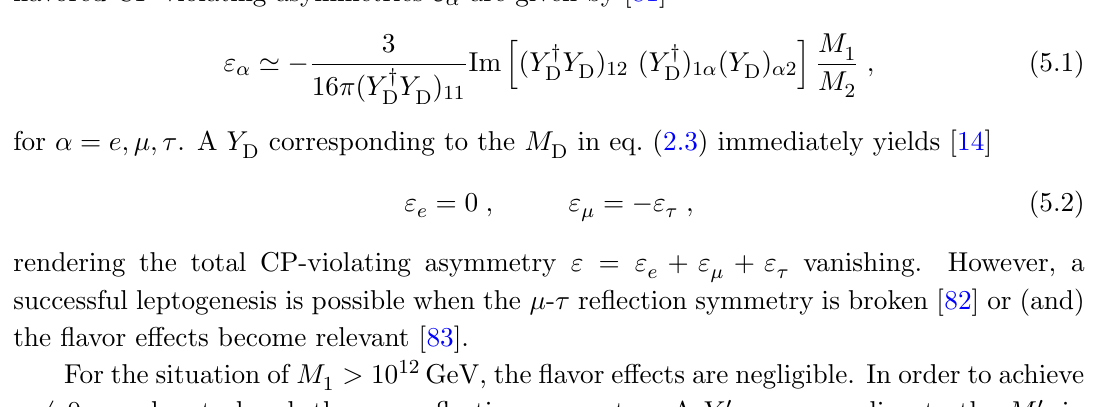
Figure 3 . The RGE-induced (cid:1) (cid:18) , (cid:1) (cid:14) and (cid:1) (cid:27) against tan (cid:12) in the MSSM. 23 baryon-antibaryon asymmetry through the sphaleron process [80]. The essential CP viola- tion is provided by the complex Yukawa couplings Y = M =v which couple N with the i D D left-handed neutrino (cid:12)elds, while the lepton-number violation originates from the Majo- rana mass terms of N . And the departure from thermal equilibrium can occur if N decay i i in a rate smaller than the expansion rate of the Universe when the temperature T drops to the mass scale of N . The produced amount of lepton-antilepton asymmetry is crucially i dependent on the CP-violating asymmetries between the decays of N and their CP conju- i gate processes. In the minimal seesaw under study, we assume N to have a strong mass 1 ; 2 hierarchy M (cid:28) M , in which case only the decay of N is relevant for leptogenesis. 1 2 1